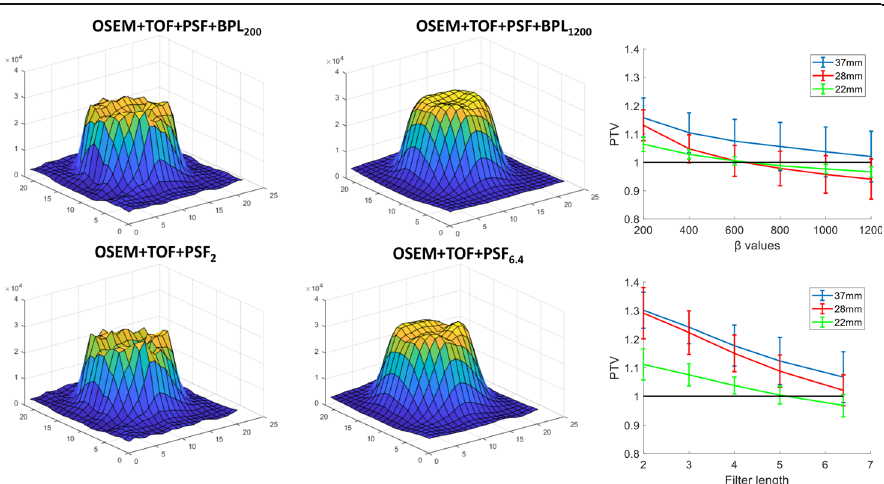
The top row refers to BPL reconstructions with increasing penalisation factor (left to right) and the bottom row to PSF reconstructions with increasing width (left to right) of Gaussian post-reconstruction filter. The averaged peak-to-valley ratios from six profiles are also shown on the right for BPL (top) and PSF (bottom) reconstructions for the 37-, 28-, and 22-mm spheres. The error bars represent the standard